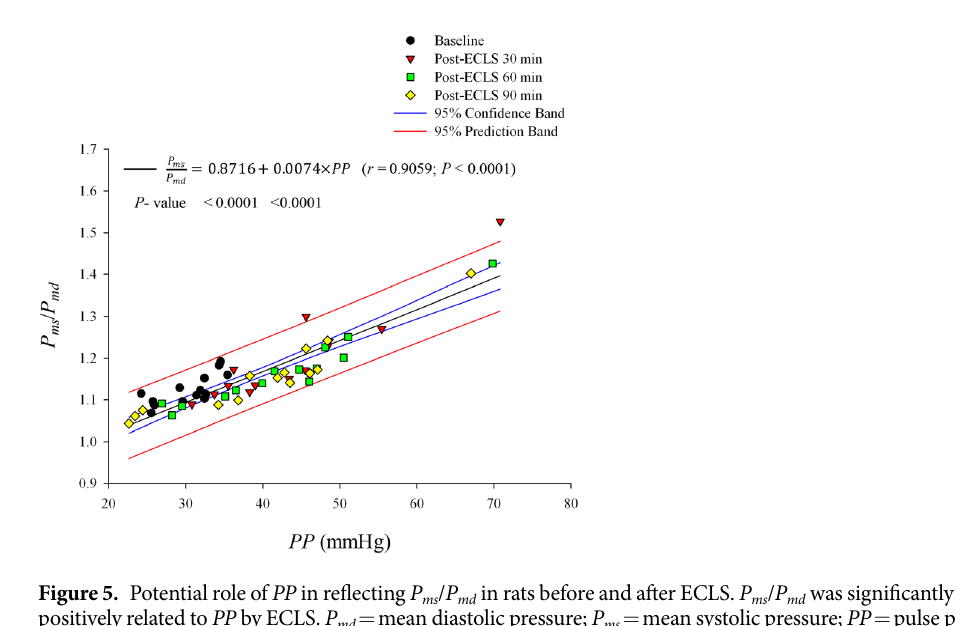
Figure 4. | P f | but not | P b | strongly correlated with P ms / P md in rats before and after ECLS. As shown by multiple linear regression analysis, the correlation between P ms / P md and | P f | and | P b | reached significance. ( A ) However, only | P f | was significantly positively related to P ms / P md before and after ECLS ( B ), indicating that the P ms / P md impaired by ECLS might be influenced by | P f | rather than | P b |. P b = backward pressure wave; P f = forward pressure wave; P md = mean diastolic pressure; P ms = mean systolic pressure.